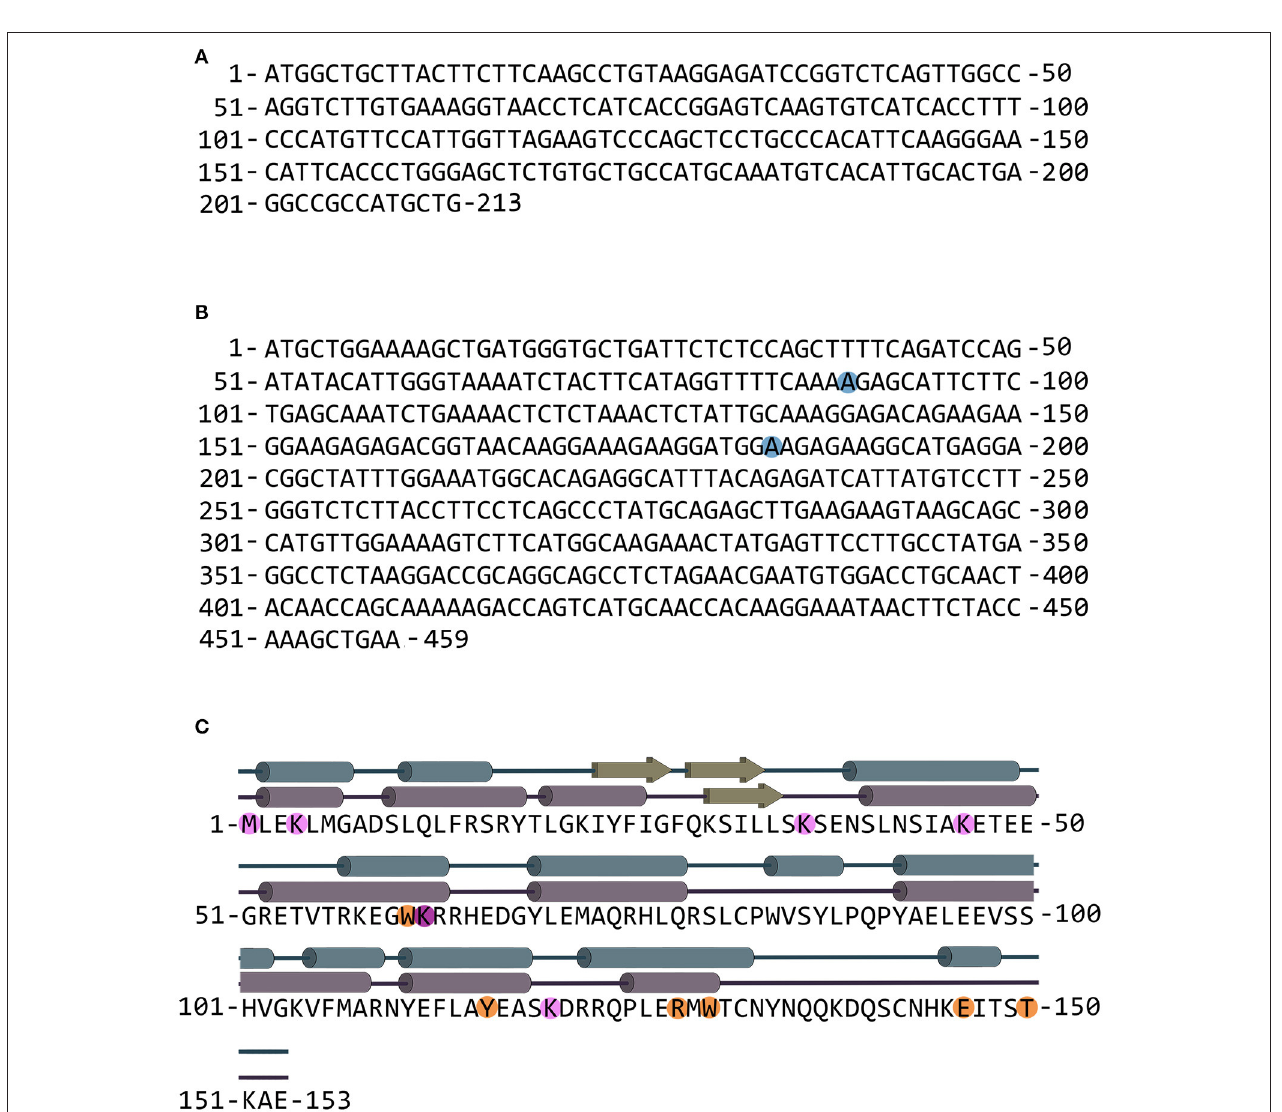
FIGURE 1 | G30 and G72 genes and pLG72 protein. (A) Nucleotide sequence of the G30 gene (genebank entry code AY138548.1); the gene is transcribed on the opposite DNA strand in comparison with G72 . (B) Nucleotide sequence of the G72 gene; blue circles indicate nucleotides that are different in SNPs rs2391191 (AGG → AAG resulting in the R → K substitution at position 30) and rs9558562 (AAG → GAG resulting in the K → E substitution at position 62). The reported sequence codes for K30/K62 pLG72 variant (genebank entry code NM_172370.4 with A at position 89). (C) Primary and secondary structure of pLG72; residues preceding the limited proteolysis sites are shown in orange and residues modified by BS 3 cross-linking reagent are shown in pink. Cross-linked K62 residue is shown in purple (Birolo et al., 2016). The secondary structure is shown according to the final homology model (blue) and as predicted by PSSpred server (purple).